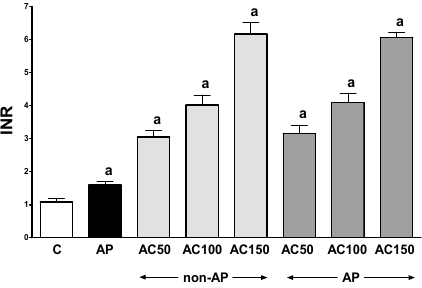
Figure 1. Impact of pretreatment with acenocoumarol on the prothrombin time measured as international normalized ratio (INR) in rats with or without cerulein-induced pancreatitis. Key: C = control; AP = cerulein-induced acute pancreatitis; non-AP = groups without induction of acute pancreatitis; AC = acenocoumarol; 50 = 50 µg/kg/day; 100 = 100 µg/kg/day; 150 = 150 µg/kg/day. Mean ± SEM. n = 10 in each group of rats. a p < 0.05 compared to control.